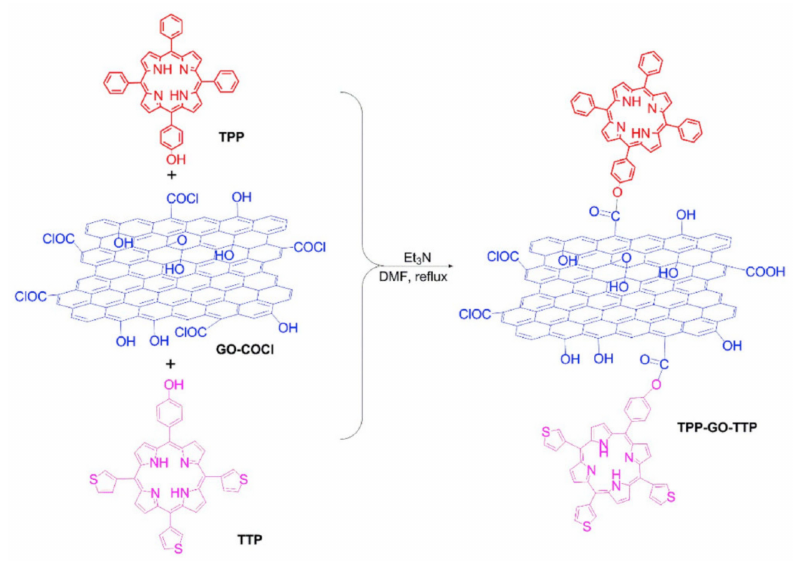
Figure 8. Synthetic route of TPP-GO-TTP (Reproduced with permission from ref. [59]. Copyright 2020 Elsevier Publications).